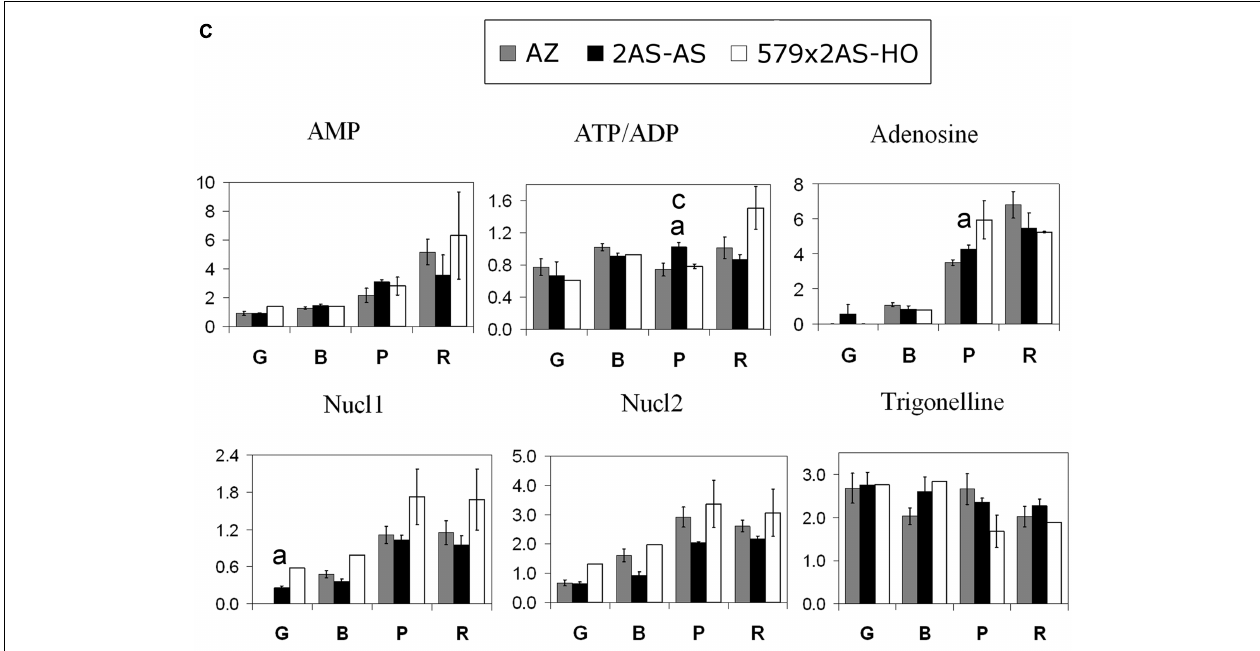
presented.The significant differences ( p -level < 0.05) between 2AS-AS and 556AZ, 2AS-AS × 579HO (labeled 579 × 2AS-HO) and 556 AZ, 2AS-AS and 2AS-AS × 579HO (labeled 579 × 2AS-HO) are denoted by letters ‘a,’ ‘b,’ and ‘c,’ respectively. G (green), B (breaker), P (pink), and R (red) refer to the stage of the fruit.